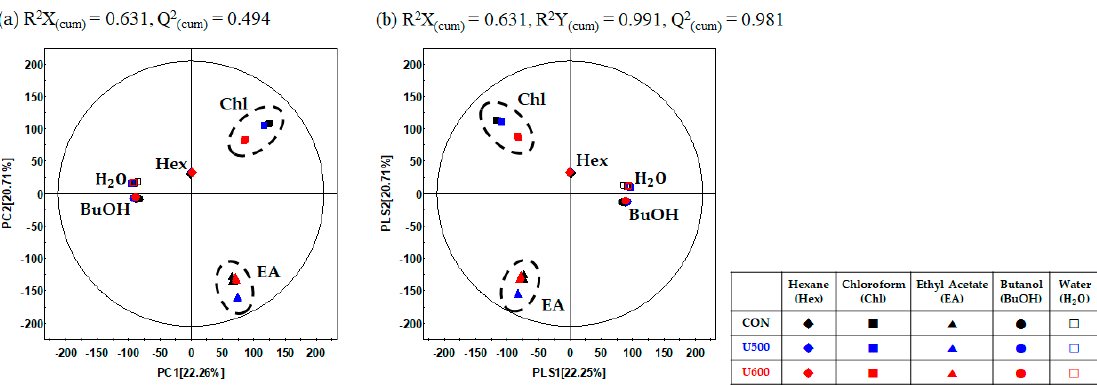
Figure 5. ( a ) PCA score plots; ( b ) PLS-DA score plots of different solvent fractions in GBP analyzed by UHPLC-LTQ- Orbitrap-MS/MS.